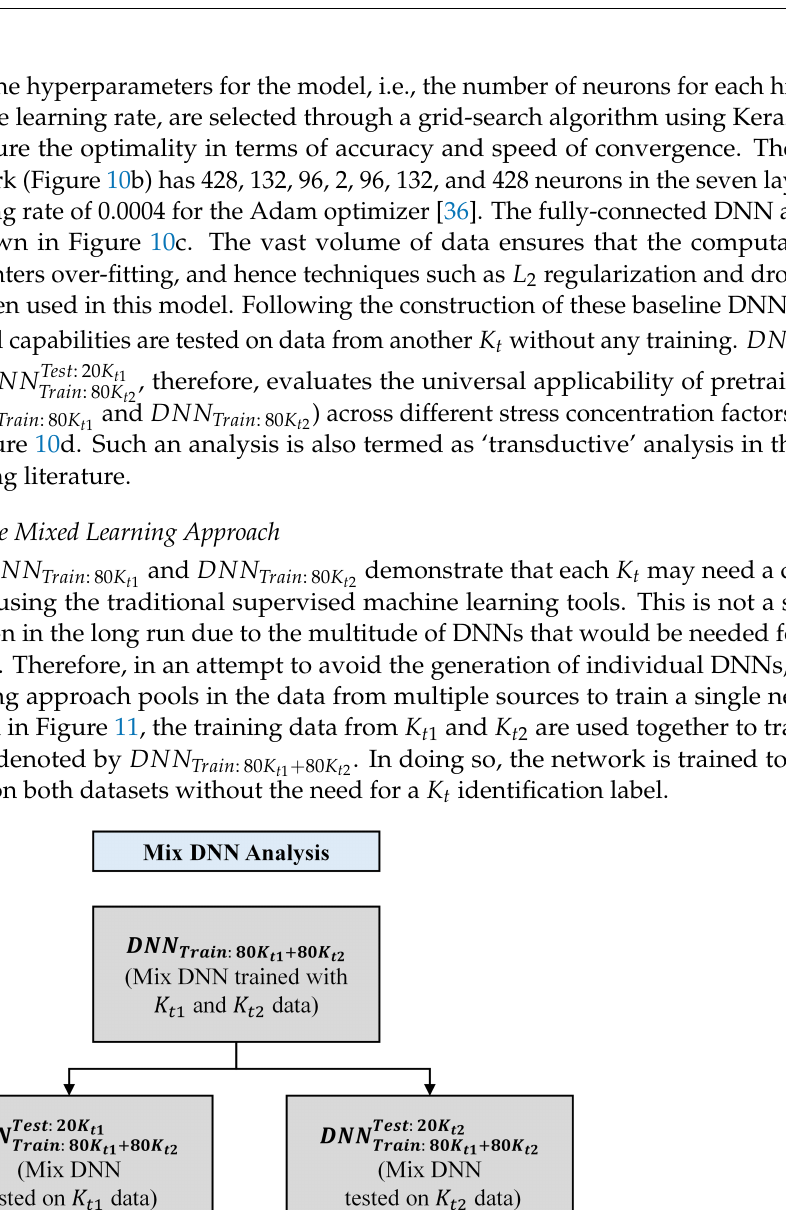
) trained using a mixed dataset comprising of t 1 + 80 K t 2